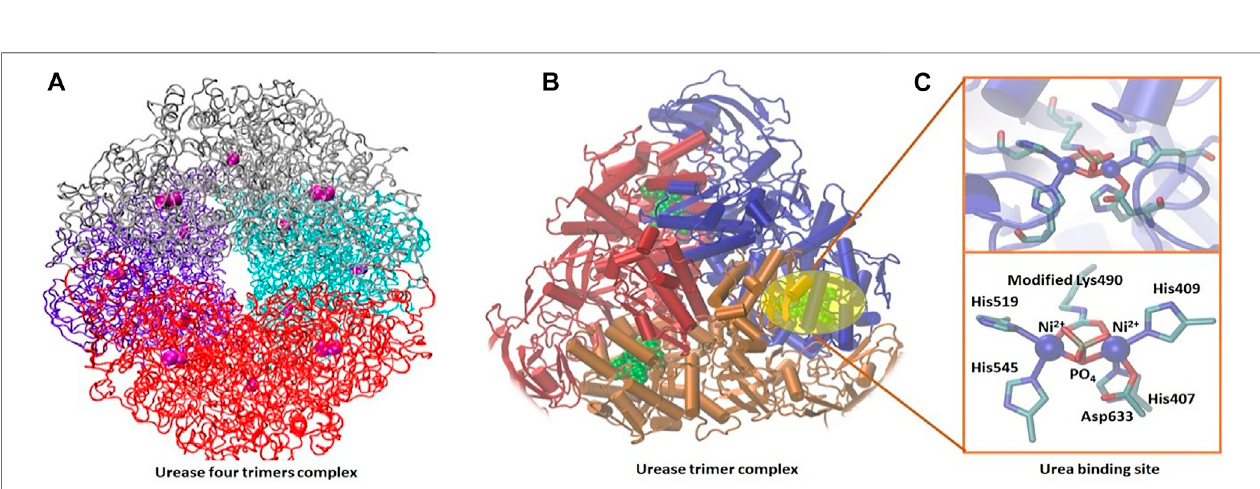
FIGURE6| Ureaseactivecomplexoffourtrimersubunits (A) (Sumanetal.,1983)andureasetrimerstructure (B) showninsecondarystructurerepresentationwith the nickel-active site shown in green. Detail of the nickel-active site is shown in balls and sticks (C) (Jabri et al., 1995).